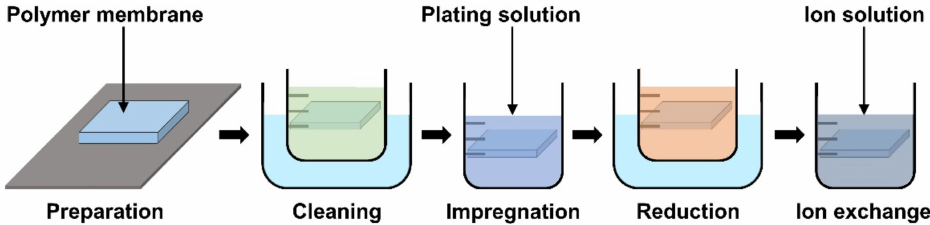
Figure 7. General manufacturing steps of IPMC using electroless plating. Adapted from Yang et al.